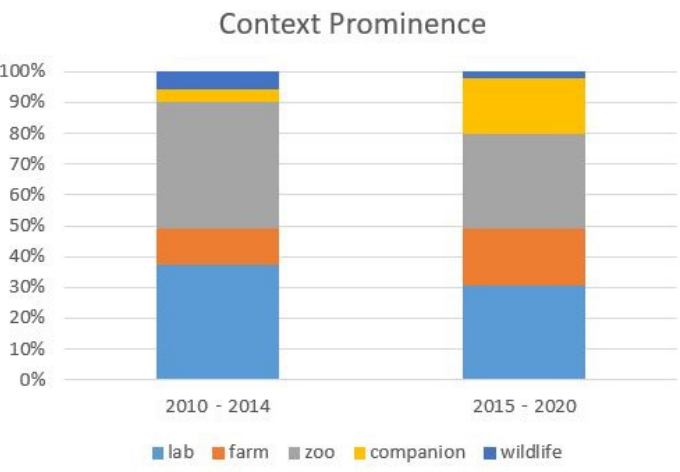
Figure 4. The distribution of contexts present in the literature as divided by the first and second half of the decade.